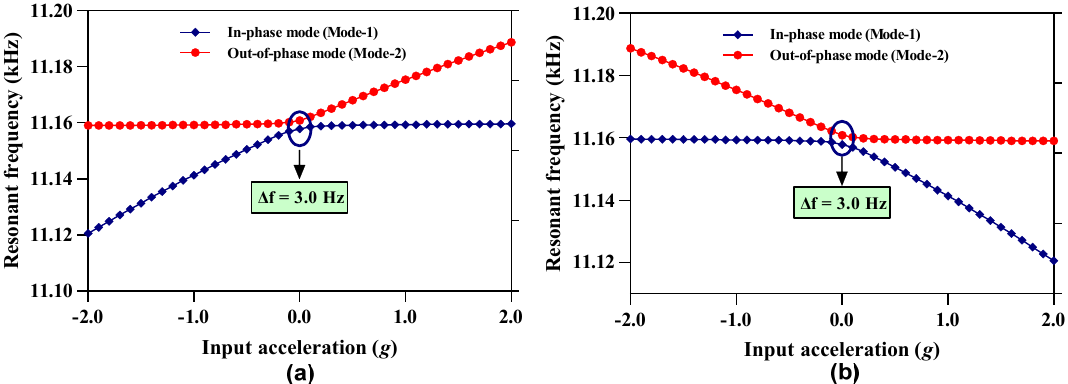
Figure 6. In-phase and out-of-phase mode resonant frequency variation with input acceleration ( a ) Resonator Set A ( b ) Resonator Set B.